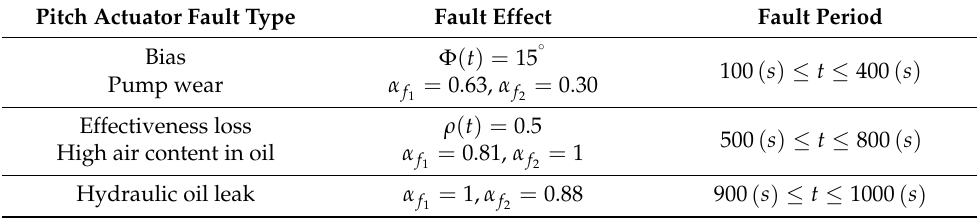
Table 3. Simultaneous fault scenario.